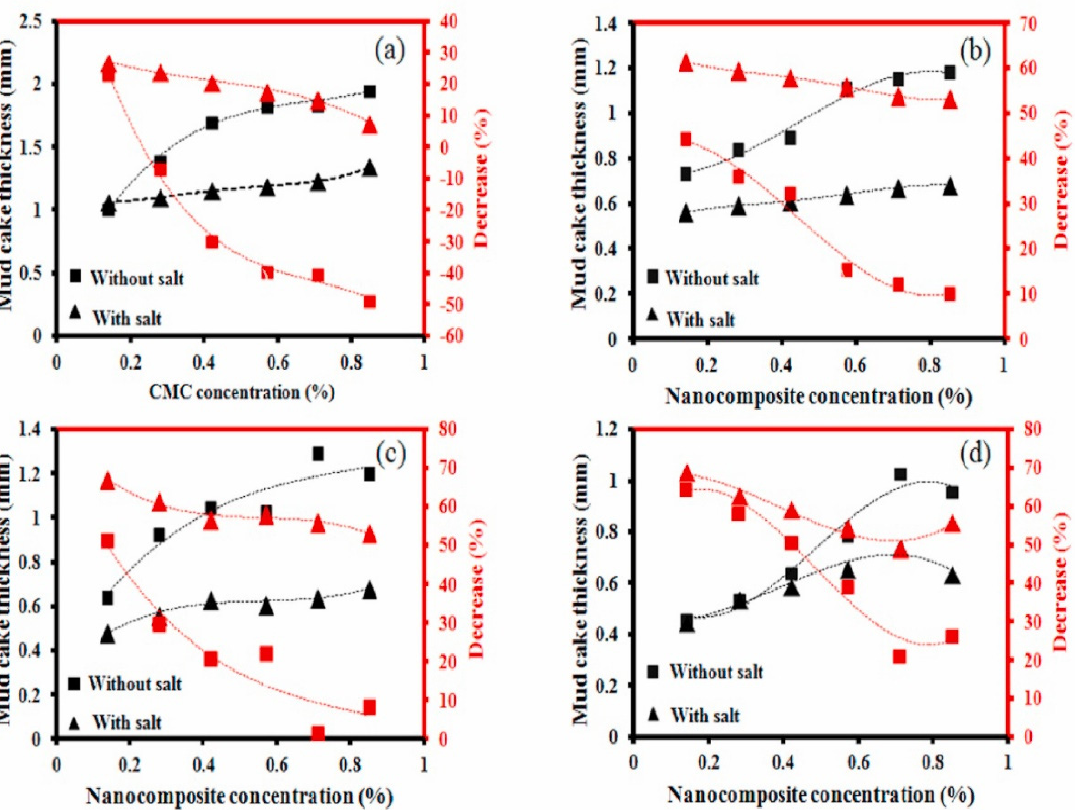
Figure 11. Mud cake thickness attained using ( a ) CMC, ( b ) 1:6, ( c ) 1:4, and ( d ) 1:3 Fe 3 O 4 -CMC nanocomposite ratios. The mud cake thickness was reduced by 44.27%, 51.14%, and 64.88%, respectively, as compared to CMC, which showed an increase in thickness of up to 48% [107].